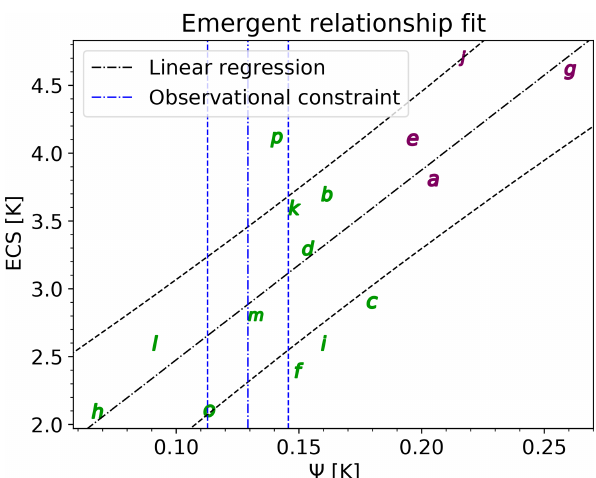
Figure 7. Emergent constraint for ECS. Shown is the relation- ship between ECS and the temperature variability metric ψ pro- posed by Cox et al. (2018). Letters show individual CMIP5 mod- els (for nomenclature details, see original publication) with lower- sensitivity models in green and higher-sensitivity models in purple. The black lines show the linear fit including the prediction error and the vertical blue lines indicate the observational mean and standard deviation given by the HadCRUT4 dataset. Similar to Fig. 2 of Cox et al. (2018) and produced with recipe_cox18nature.yml (see details in Sect. 3.3.1, “Global temperature